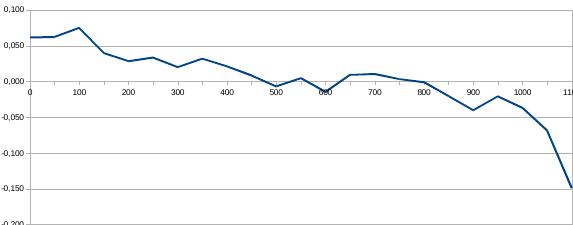
Figure 4: Differences in height (m) alongside the dyke, between the interpolated DTM and the levelling